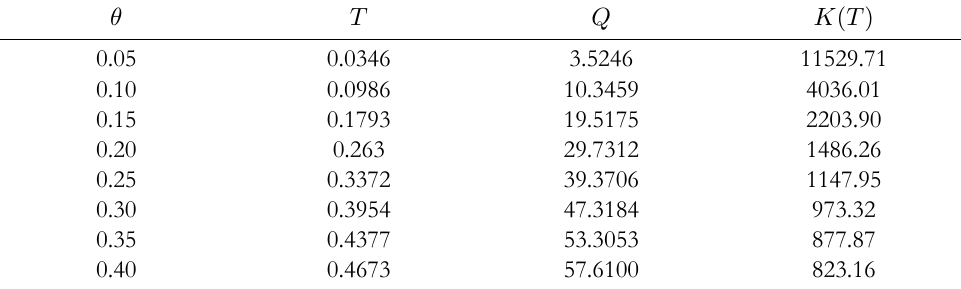
Table 7: Variation in T , Q & K ( T ) with deterioration rate ( (cid:18) )